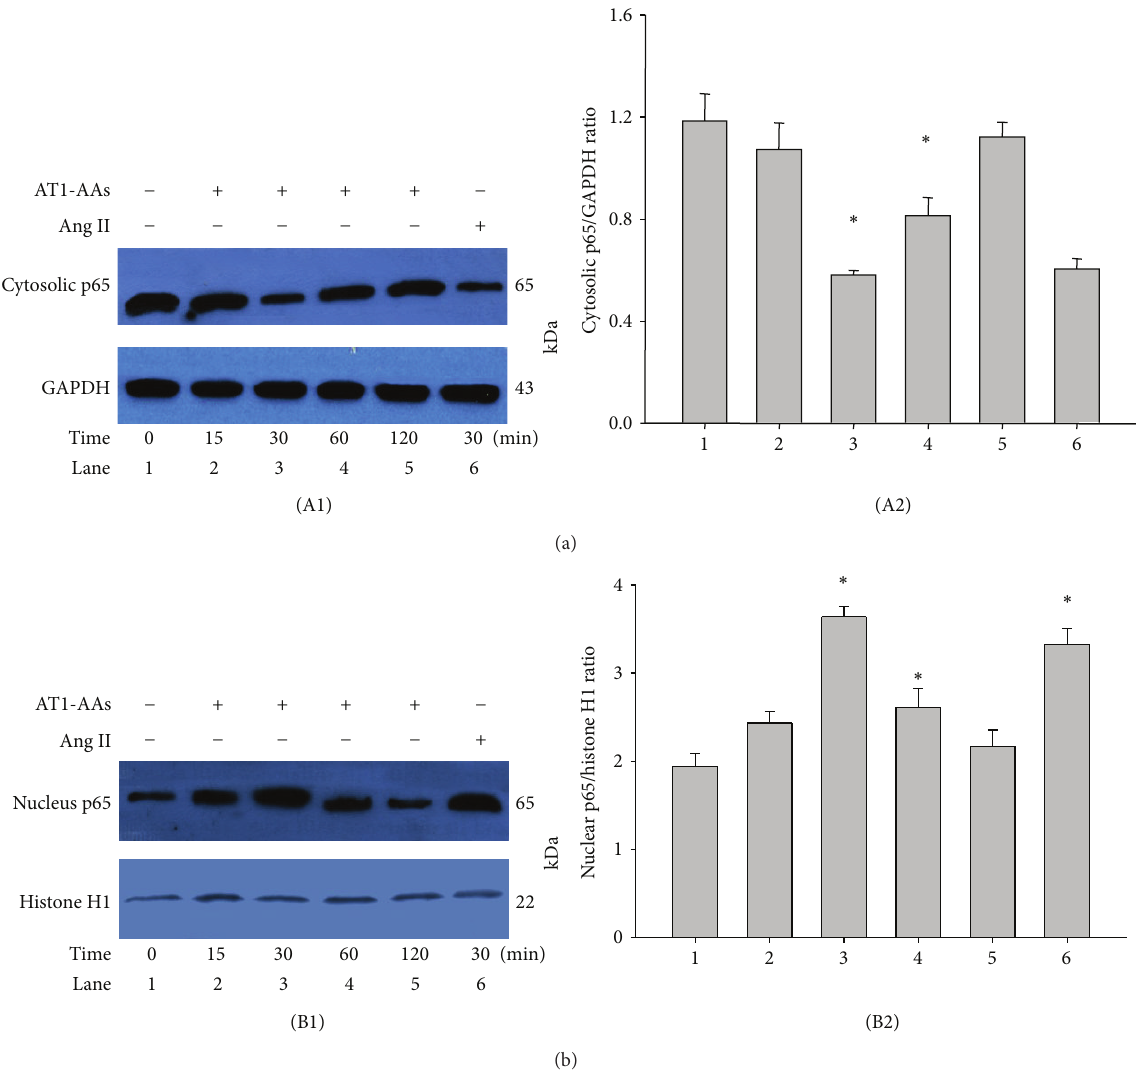
Figure 7: NF- 𝜅 B p65 expression in human endothelial cells stimulated by AT1-AAs. After incubation with AT1-AAs (0.1 𝜇 M) for 0, 15, 30, 60, and 120min and angiotensin II (0.1 𝜇 M) for 30min, p65 levels were determined by Western blot analysis. Panel (a): cytoplasm of p65 levels; panel (b): nucleus of p65 levels. Angiotensin II was used as positive control; ∗ 𝑃 < 0.05 versus 0min (control) group; 𝑁 = 5